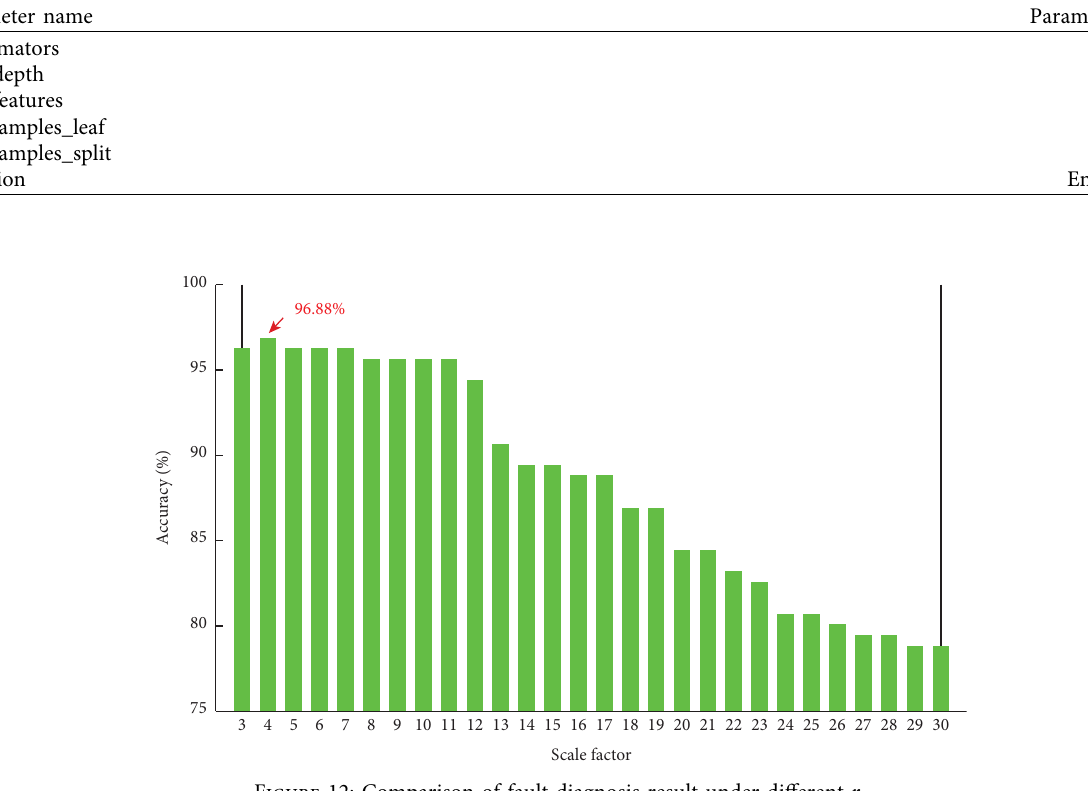
Figure 12: Comparison of fault diagnosis result under diferent r .